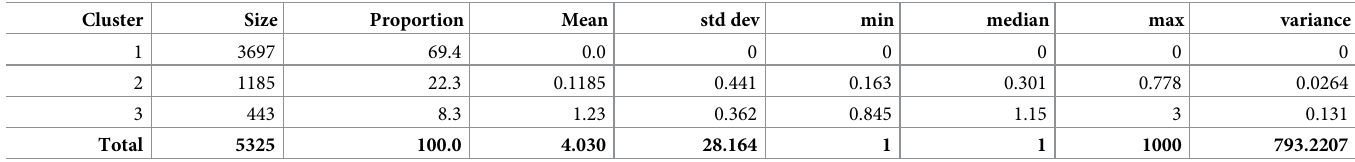
Table 3. Summary statistics for univariate clustering using ckmeans algorithm for log-transformed data for Barrow Island from 2009 to 2015.